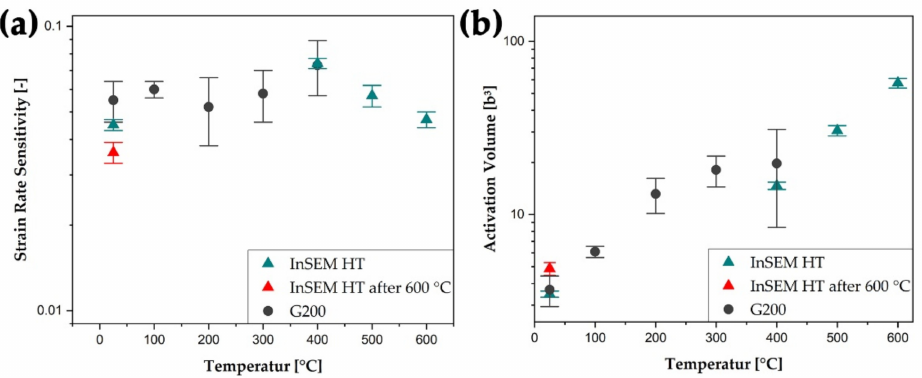
Figure 5. In ( a ) the strain rate sensitivity and ( b ) the calculated activation volume of the nc W/Cu composite are plotted as a function of testing temperature. The activation volume was normalized to the cubed Burgers vector (b 3 ) to enable comparison between different material systems [26,28]. The round markers indicate G200 and the triangular ones the InSEM-HT data points, respectively. Red triangles depict measurements at RT, which were performed after heating and testing up to a temperature of 600 ◦ C. For a colored version of this article, the reader is referred to the online